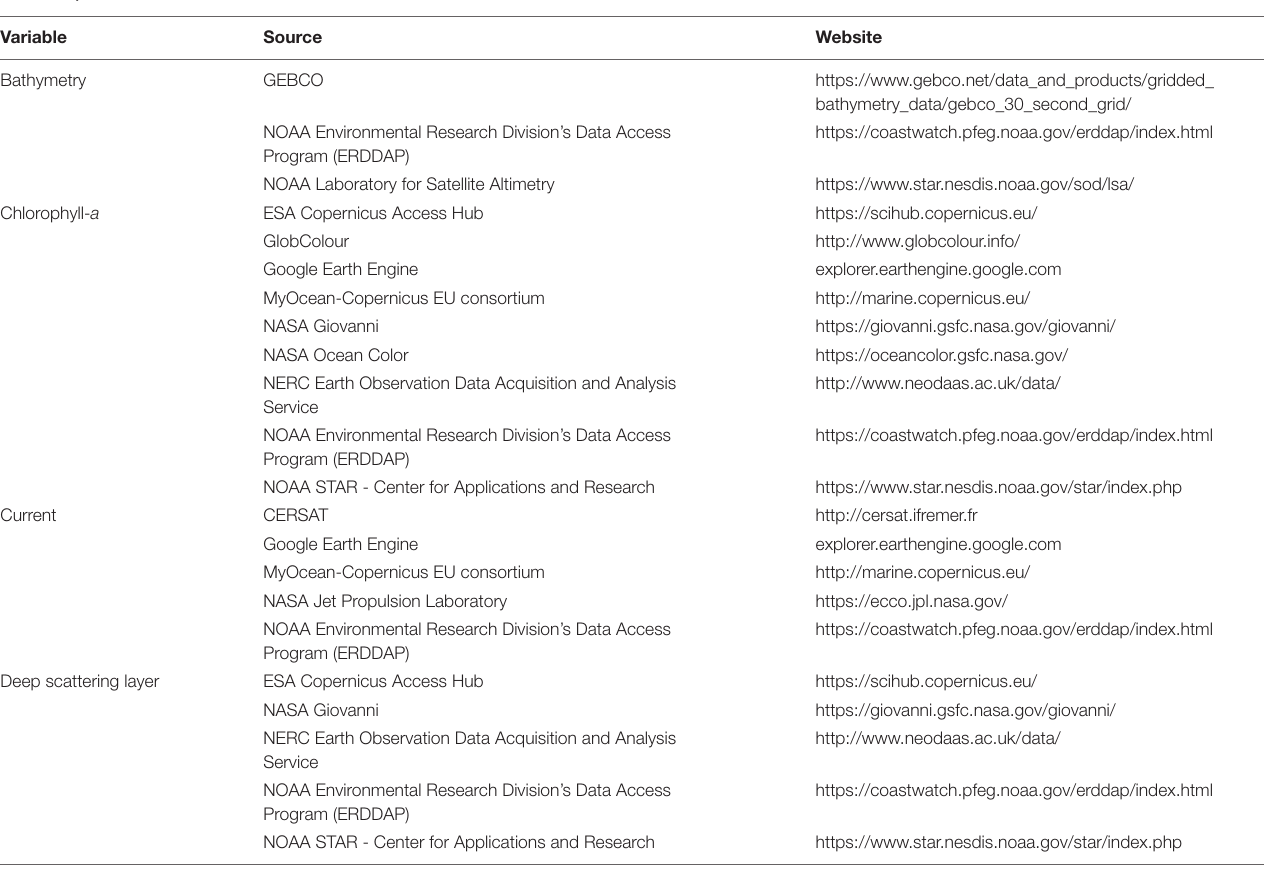
TABLE 2 | Common sources of data for SRS environmental